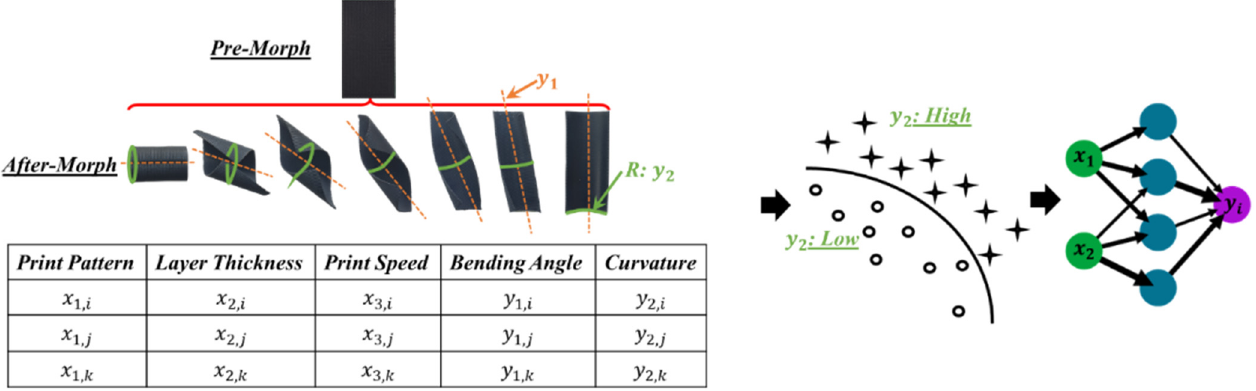
Figure 3. Overview of the proposed process–performance model.